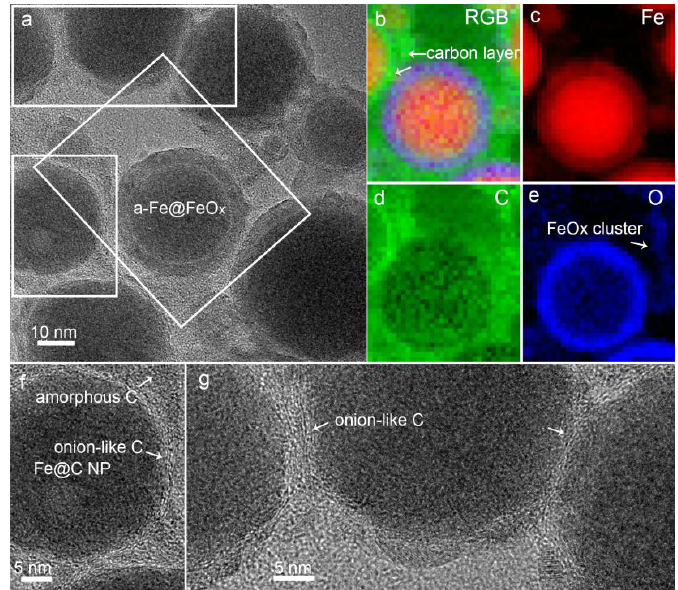
Figure 3. ( a ) TEM image and ( b – e ) EDX mapping of a Fe@FeO x core-shell particle. ( b ) TEM image of mixed elements of ( c ) Fe, ( d ) C and ( e ) O images. ( f , g ) TEM images of the Fe@C particles.